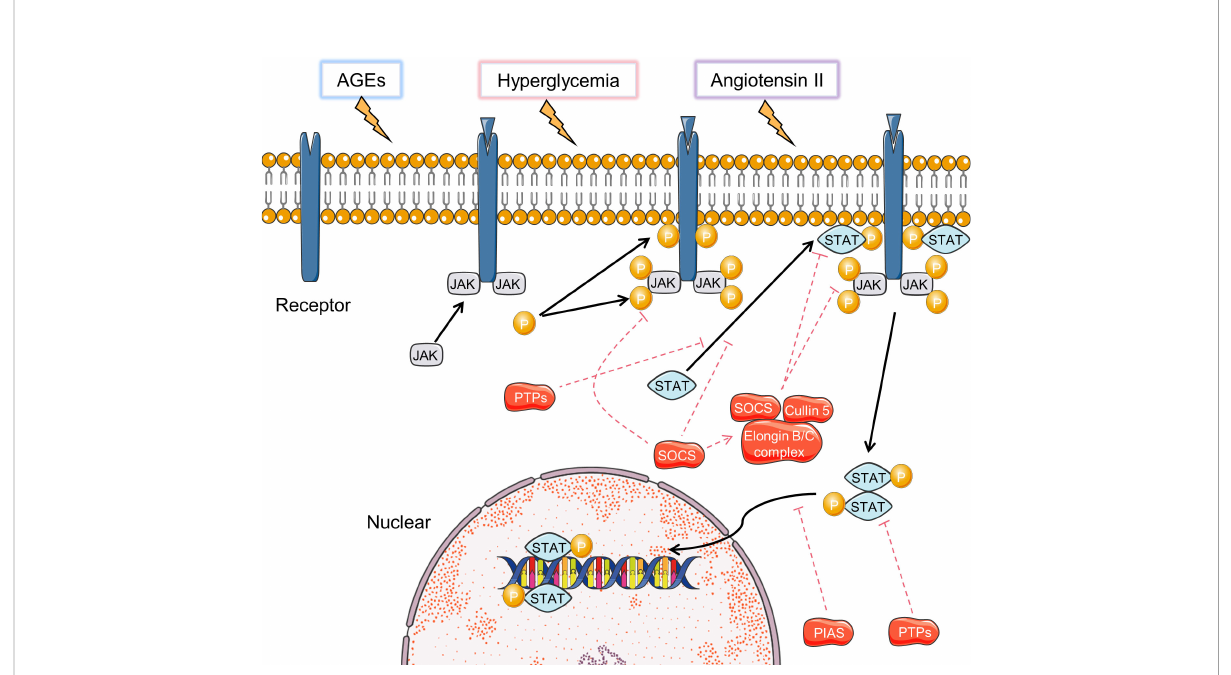
FIGURE 4 Activation and inhibition of JAK-STAT signaling pathways. Black arrows indicate the activation process and the red dotted arrows indicated inhibition